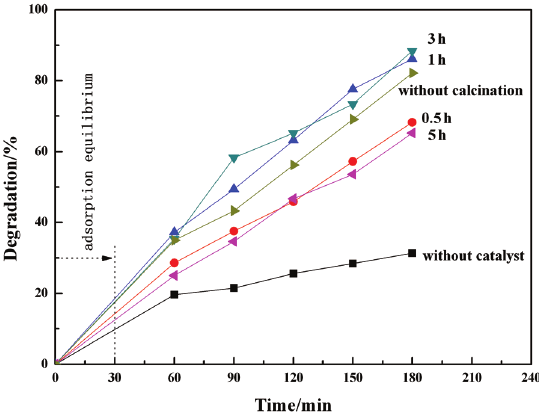
Figure 6: Degradation charts of BiVO 4 samples with for different heat treatment